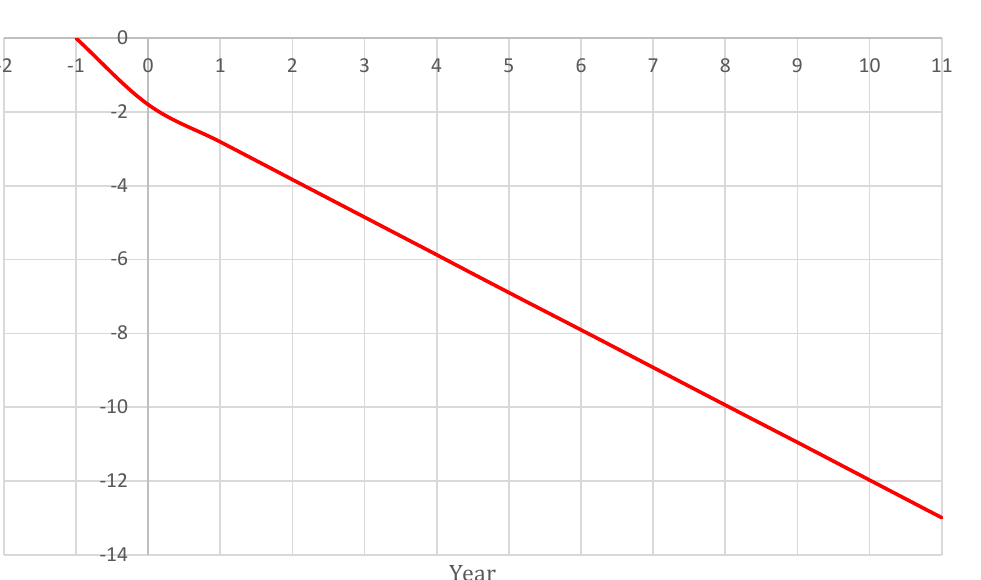
Figure 3. Cumulative cash flow graph for conversion process of HDPE to pyrolysis oils at a feed rate of 100 kg/h and a sale price of £60/barrel.